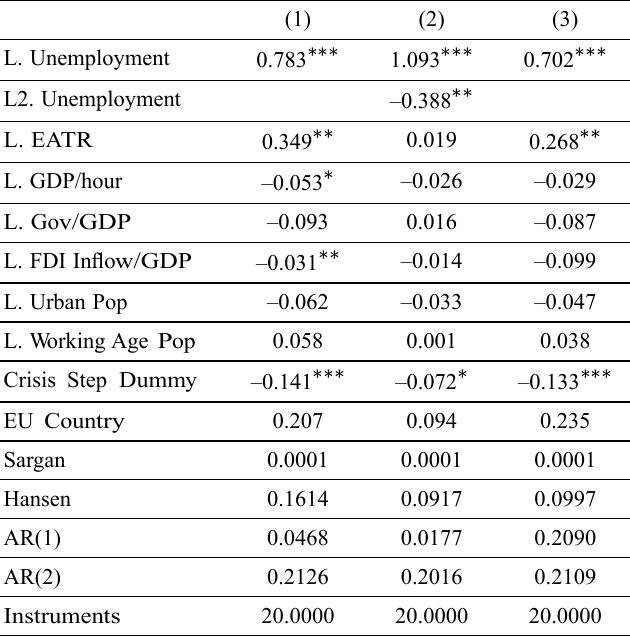
Table 6. Estimation results with lagged